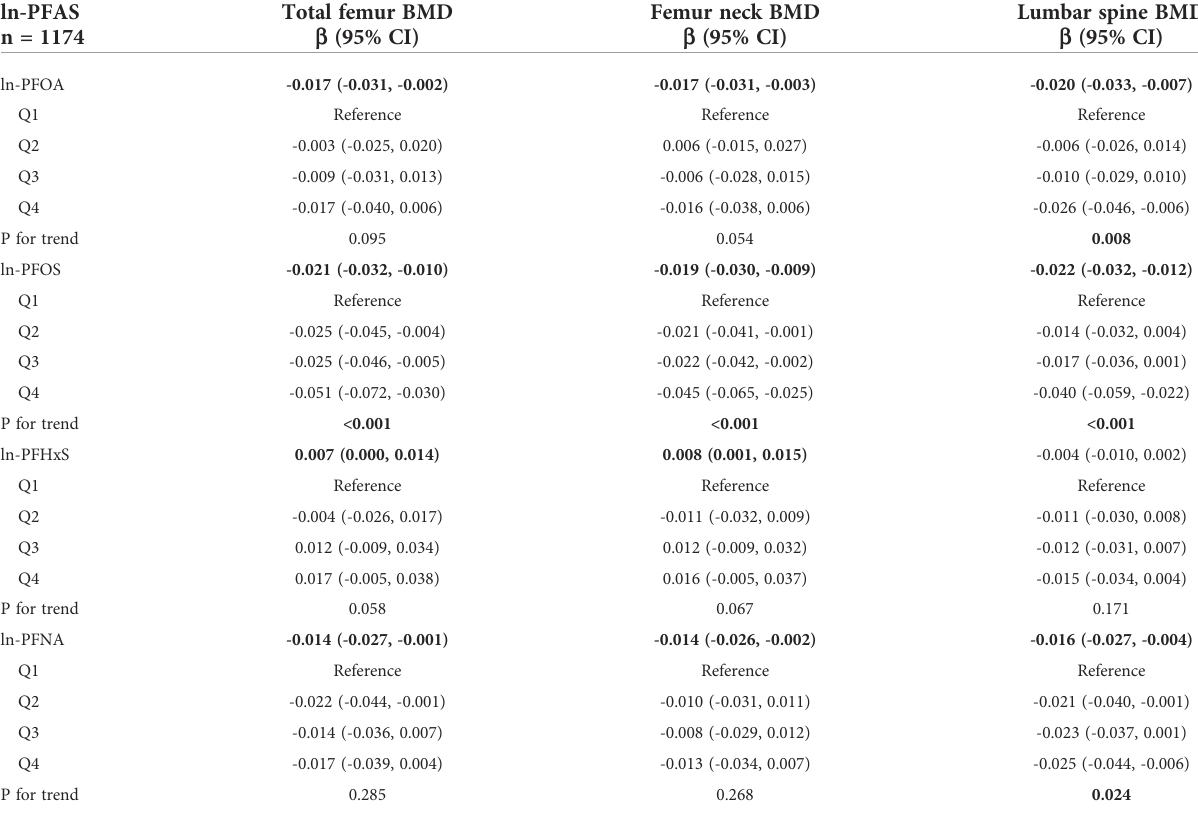
TABLE 2 Association between PFAS concentrations and BMD in young adults aged 12-19 years, NHANES